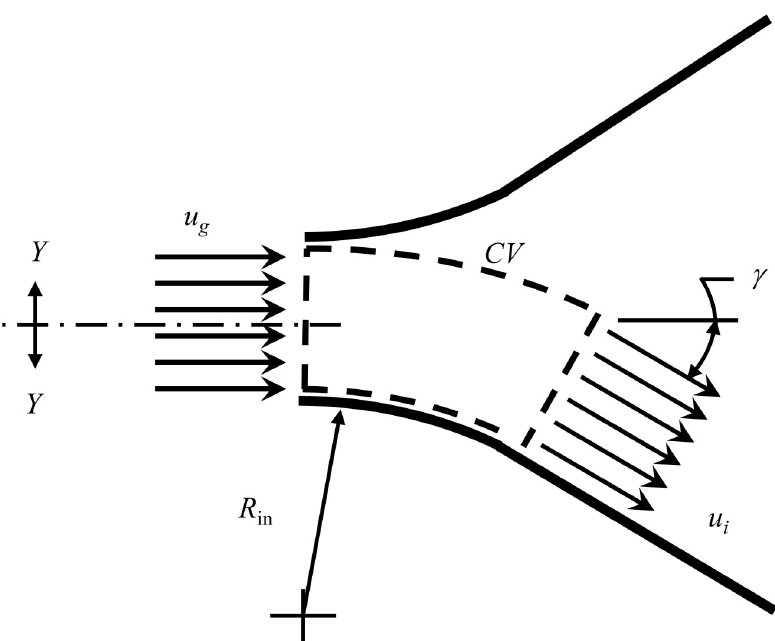
Fig 2. Schematic of the glottal fluid and acoustic model domain. Region (1) denotes where the effects of flow curvature are modeled, while (2) identifies where the Boundary Layer Estimation of the Asymmetric Pressures (BLEAP) model is applied. [28]. Locations of interest are identified as: s —subglottal; g —glottis, i —inlet, e —exit, v t— vocal tract.